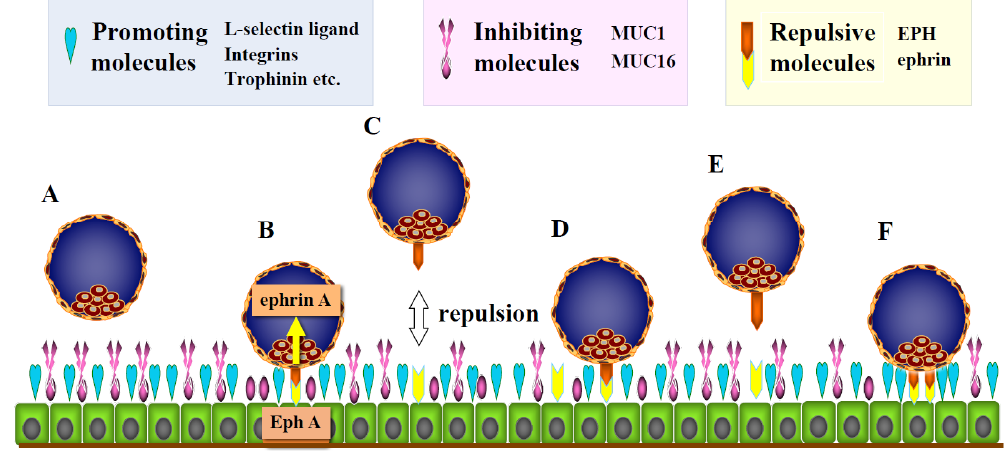
Figure 2. Possible mechanisms to create an adequate period of cross-talk between the embryo and mother before attachment by repulsive forces. ( A ) During human embryo implantation, several adhesion-promoting molecules, such as trophinin, L-selectin ligand, and integrin αVβIII,